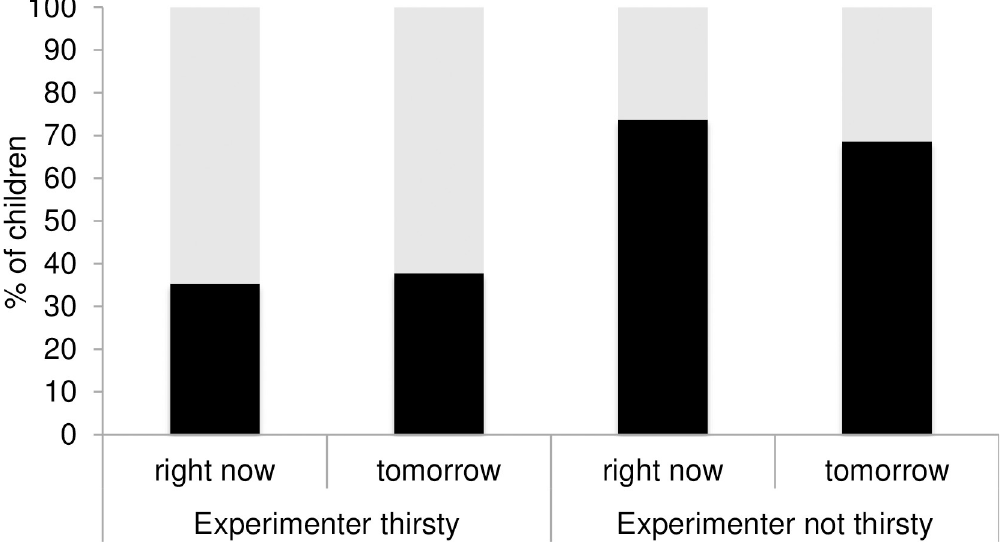
Fig 1. Percentage of children choosing crisps (in black) and water (in grey) for the experimenter in the “right now” and “tomorrow” conditions as a function of the experimenter’s current state (e.g., thirsty, not thirsty). https://doi.org/10.1371/journal.pone.0259159.g001 PLOS ONE | https://doi.org/10.1371/journal.pone.0259159 November3,